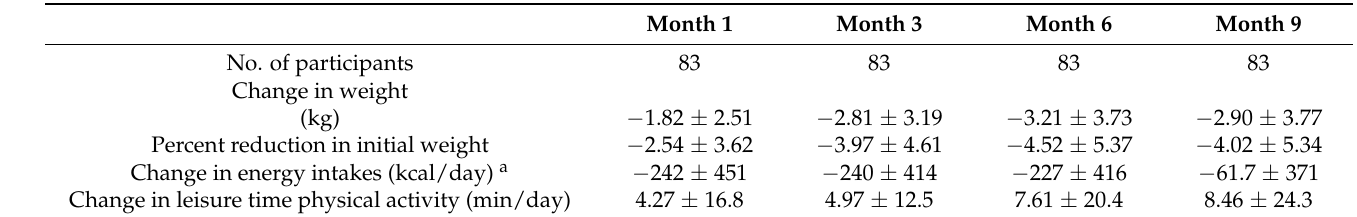
Table 2. Changes in body weight, energy intake, leisure time, and physical activity from baseline to the end of Months 1, 3, 6 and 9.